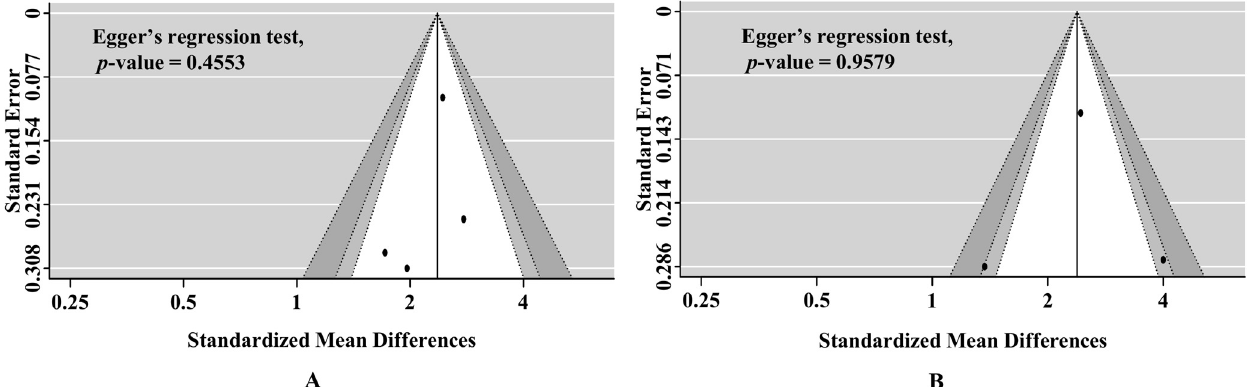
Figure 5. Funnel plot and Egger’s regression test to assess for publication bias. ( A ) Publication bias for percent constriction of pupillary light reflex at 0–24 h after hospital admission and neurological outcome. ( B ) Publication bias for percent constriction of pupillary light reflex at 24–48 h after hospital admission and neurological outcome.